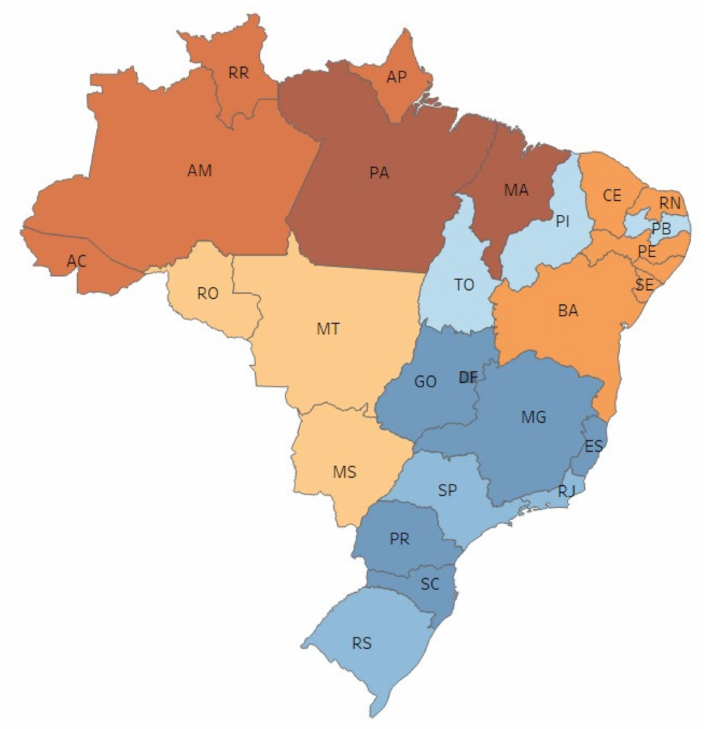
Figure 7. Map of Brazil generated from the result of the dendrogram with eight clusters (age group aged 64 and over). States well distributed in the clusters, showing heterogeneity in the behavior of the